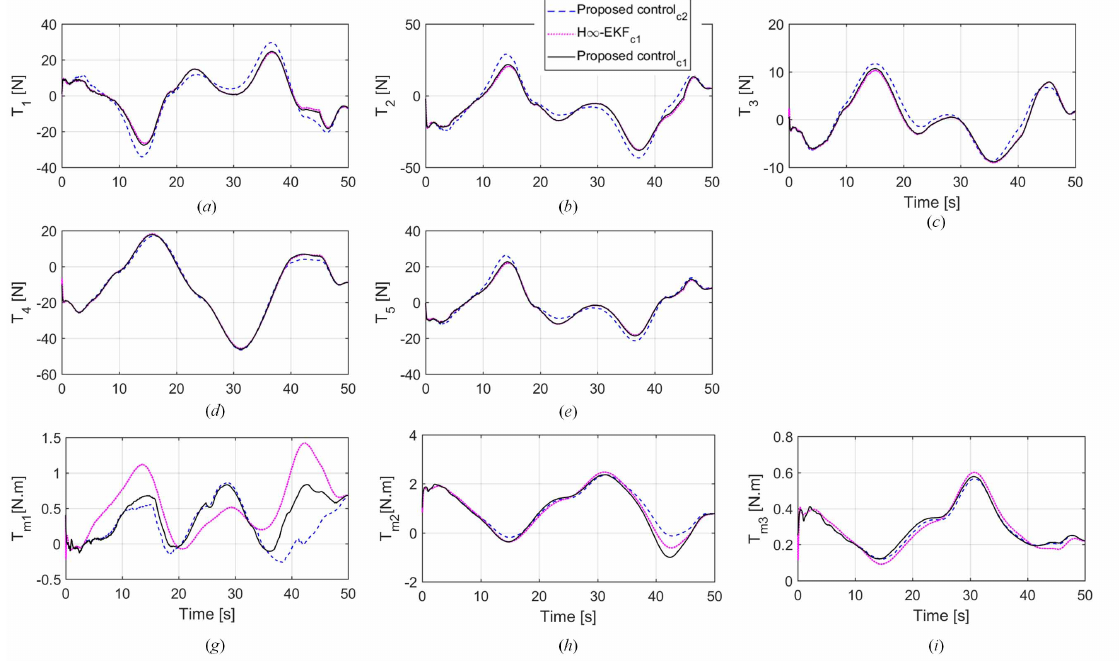
Figure 13. Thruster forces and actuator torques for the circular trajectory tracking. ( a – e ) Thruster forces T 1 , T 2 , T 3 , T 4 and T 5 ; ( g – i ) actuator torques T m 1 , T m 2 and T m 3